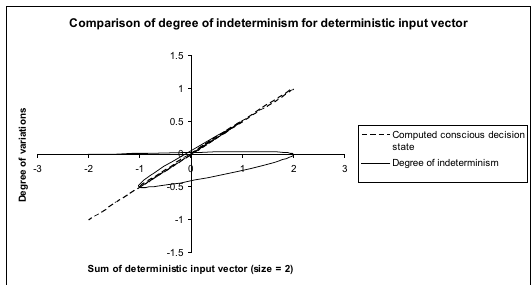
Fig. 10. Variation of state of consciousness in C1 (size = 2). Comparison of degree of indeterminism for combinatorial input vector